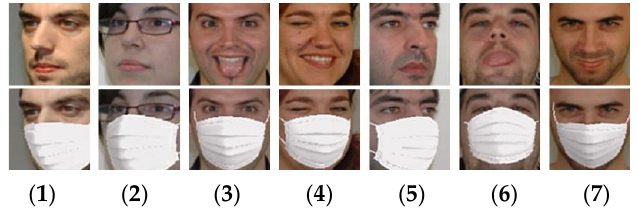
Figure 3. Image pairs of unmasked face and masked face used for learning the mask pattern generator. The masked face images are obtained by using the SNOW application. The pose views of the used faces can be roughly categorized into seven groups (left-to-right): ( 1 ) − 45~60 degrees; ( 2 ) − 15~30 degrees; ( 3 ) frontal; ( 4 ) + 15~30 degrees; ( 5 ) + 45~60 degrees; ( 6 ) up; and ( 7 ) down.